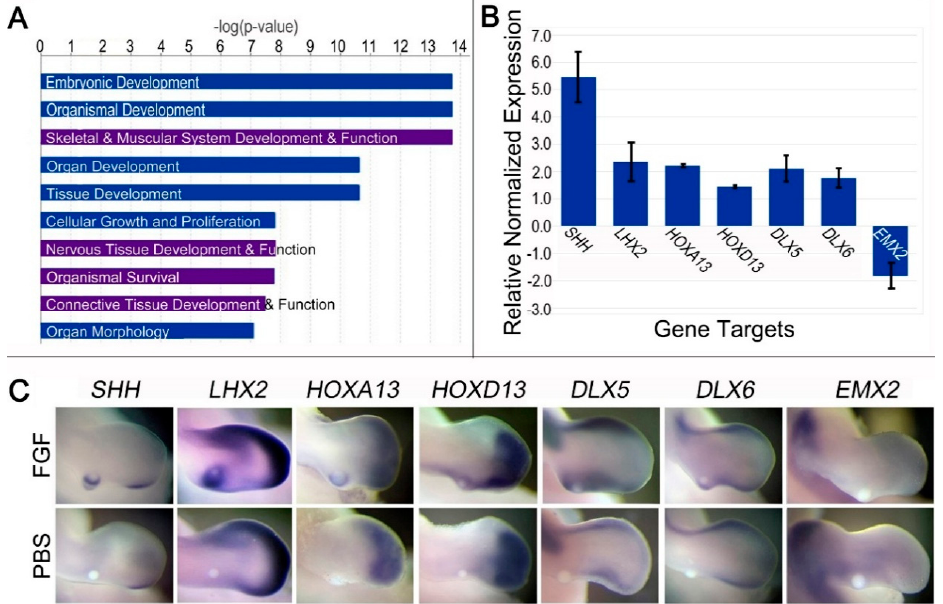
Figure 3. Prolonged (24 h) FGF treatment in the mid-proximal limb bud promotes distalization, supports processes involved in embryonic development, and leads to SHH induction. ( A ) Top pathways and biological processes affected by 24 h of FGF treatment. Purple bars indicate top pathways affected that differed from the 3 h transcriptome analysis. ( B ) RT-qPCR validation of FGF-mediated expression of target genes. The y-axis shows the relative normalized expression of selected target genes. Assays were performed in triplicate and at least two independent experiments were performed. Expression of each gene was compared to the same region on the contralateral limb buds ( p < 0.05 for each comparison). ( C ) WMISH of distally restricted transcription factors confirm their regulation in response to 24 h of FGF exposure. Top panel shows upregulation/downregulation in response to ectopic FGF when compared to a PBS-treated limb (control; bottom panel). n = 6 embryos per gene for FGF treatment and 3 embryos per gene for PBS. Note that EMX2 is strongly expressed proximally, but has a weak distal expression that was reduced by FGF treatment after 24 h. Of note, an abundance of differentially regulated genes encoding Wnt signaling proteins were detected (n = 46). Wnt proteins are involved in limb initiation, outgrowth, cell migration, cell differentiation, and patterning [38,39]. This led us to question whether a Wnt pathway might be